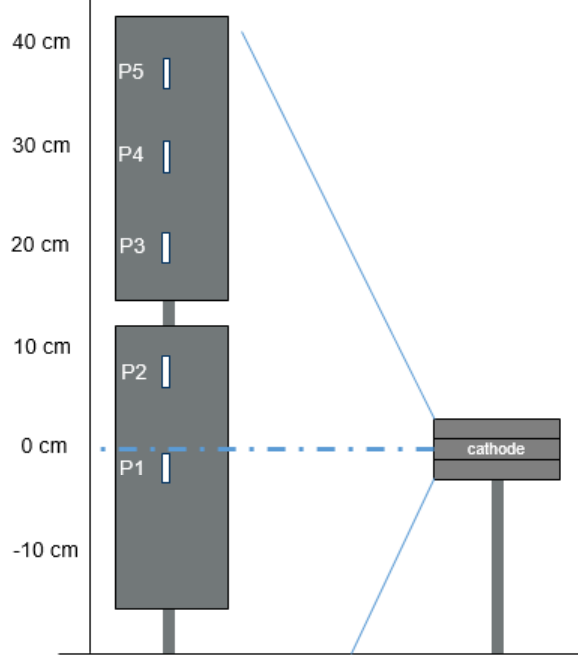
Figure 3. Scheme of the vertical sample position relative to center of the cathode (P1–P5) with a minimal distance of 65 cm (cathode surface (Figure 2; no. 3) to the sample holder (Figure 2; no. 7) and a maximal distance of 100